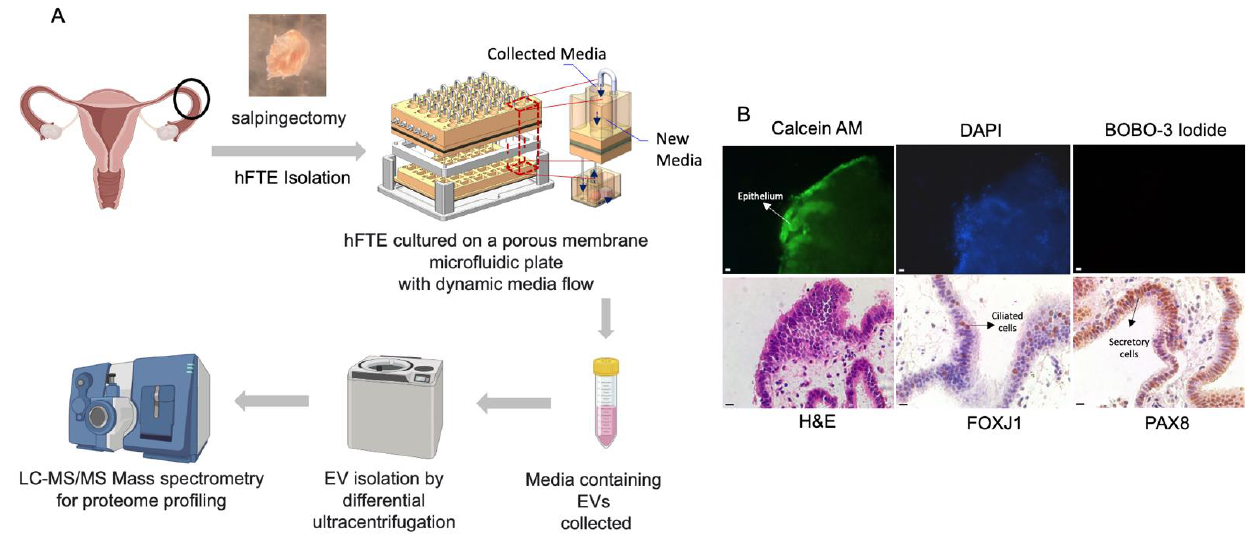
Figure 1. The fallopian tube explants were cultured in a microfluidic platform for sEV collection. ( A ) The workflow of hFTE-derived EV proteomics characterization. ( B ) The live/dead staining of hFTE epithelium cultured in the PREDICT-MOS for six days. The green fluorescence (calcein) indicates live cells, and the red fluorescence indicates dead cells, labeled by BOBO-3 iodide. Immunohistochemistry staining of FOXJ1 and PAX8 confirmed that the hFTE maintained the two major epithelial cell populations, ciliated and secretory cells, after six-day dynamic culture on the PREDICT-MOS. Scale bar = 10 µm.